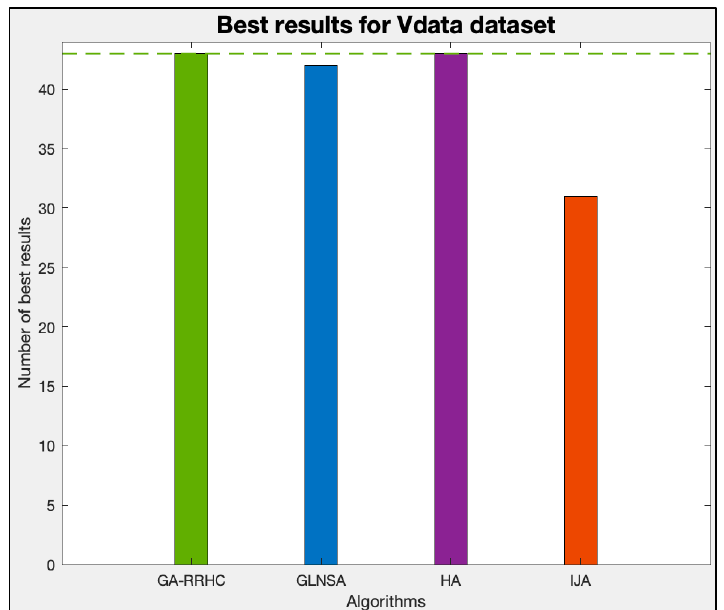
Figure 18. Number of best results per algorithm for the Vdata